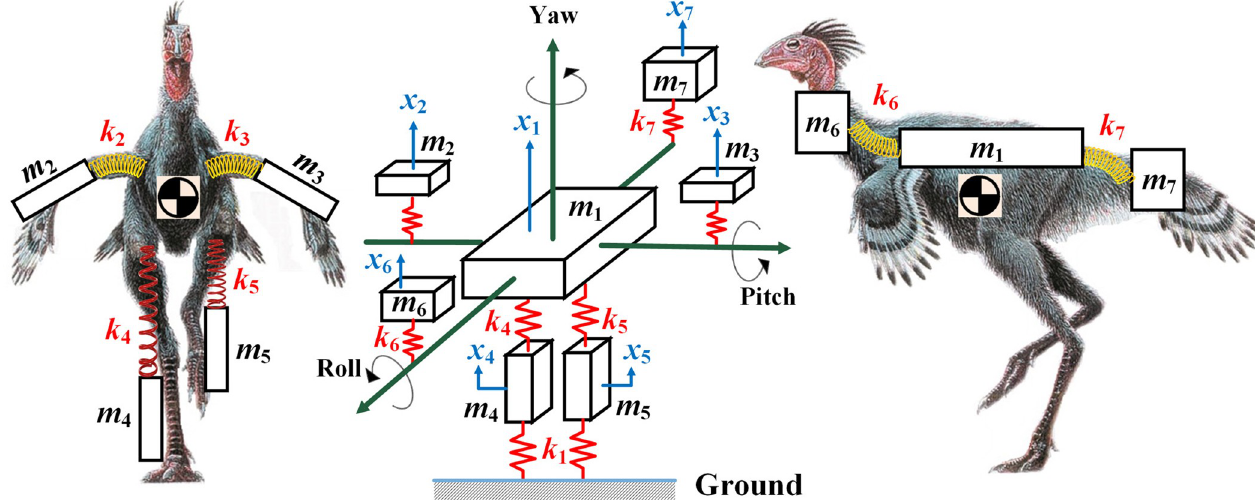
Fig 1. Seven-rigid-body system of Caudipteryx . The simplified rigid body system illustrates the mechanism of moving parts, main body, wings, legs, neck and head, and the tail of the Caudipteryx . The masses of all parts are represented by lumped mass points and the muscles at the joints are replaced with springs (As damping coefficient does not significantly affect the natural frequency, we simplified the joints which are composed of tendons, muscles, ligaments and soft tissues as purely elastic springs with no damping). Different effective masses of these seven primary modes of the simplified Caudipteryx show different possibilities to be